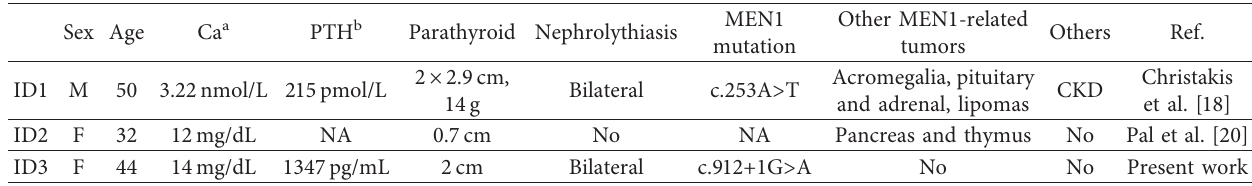
MEN1 Other MEN1-related Others mutation tumors